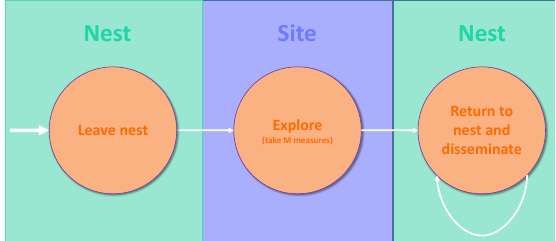
Figure 1. Robot’s behavior described as a finite state